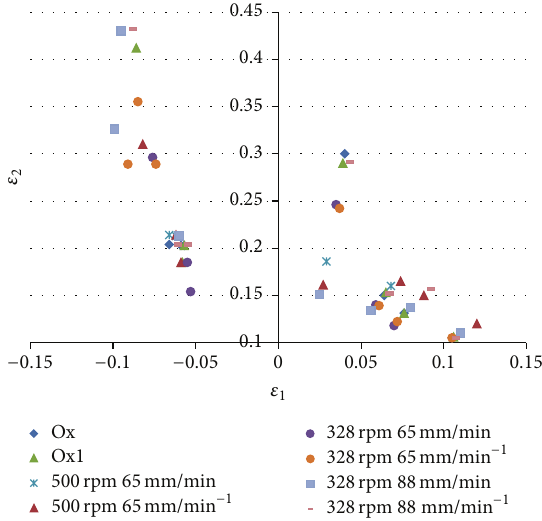
Figure 34: FLD diagram results for